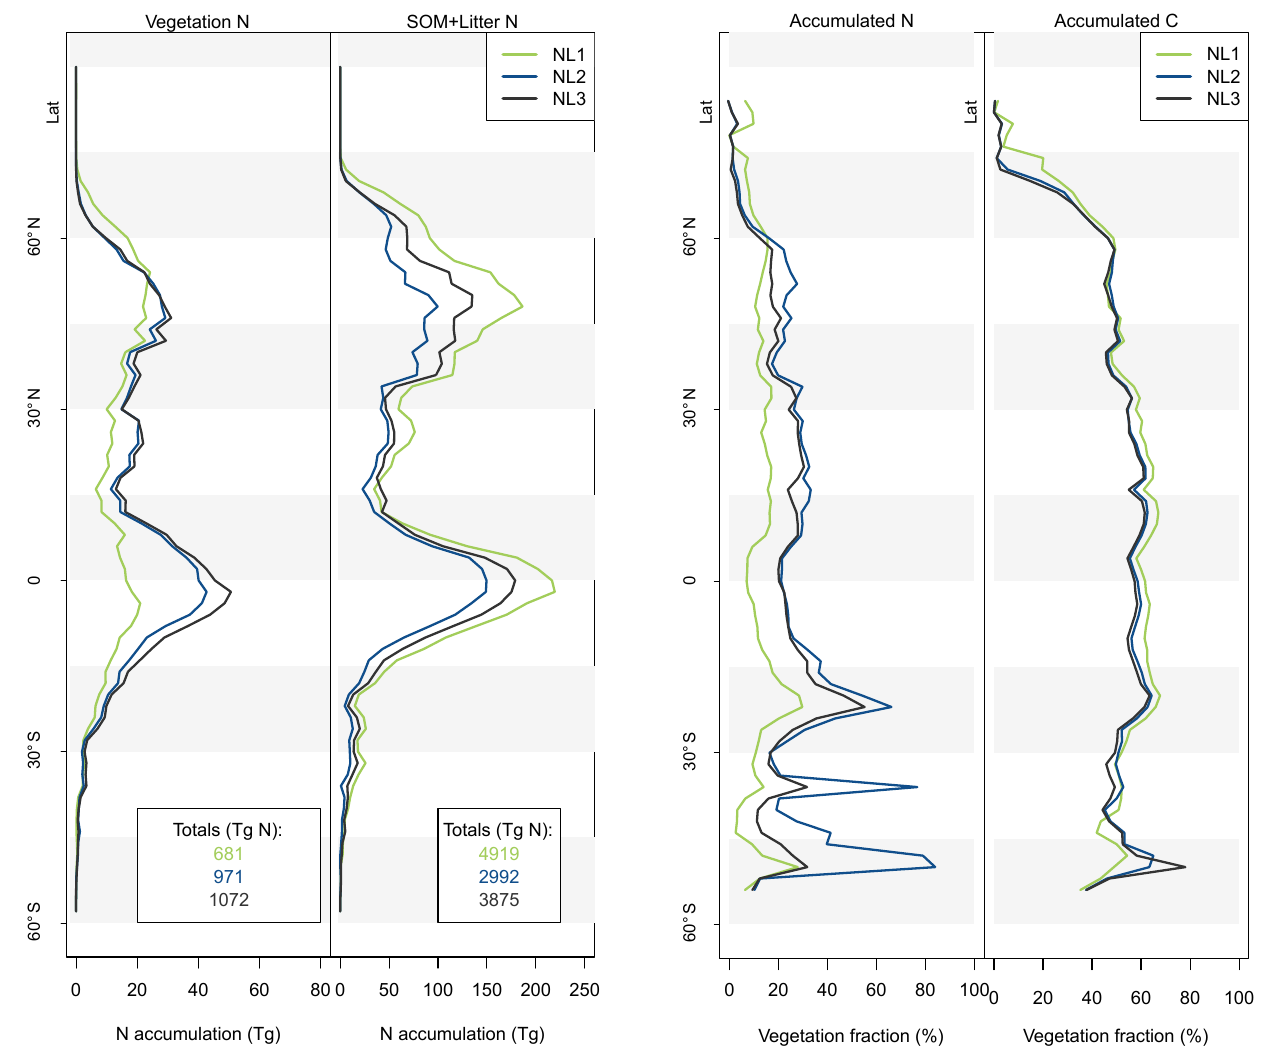
Figure A2. Latitudinal vegetation fractions of accumulated nitro- gen (N, left) and carbon (C, right) during global simulations of elevated atmospheric CO 2 concentrations (eCO 2 ) using three dif- ferent N loss algorithms between 1850 (285ppmCO 2 ) and 2100 (936ppmCO 2 ), depicted per 2 ◦ latitudinal band. The inverse of the vegetation fraction corresponds to material accumulated in soil or- ganic matter or litter